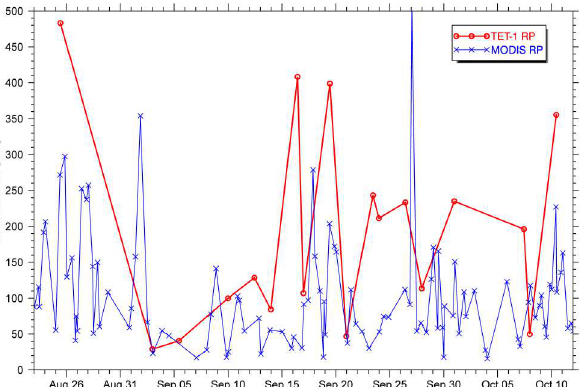
Fig. 4. Comparison of radiant power estimated from TET-1 and MODIS data. TET-1 provides in general higher values due to its finer resolution but its observations are less